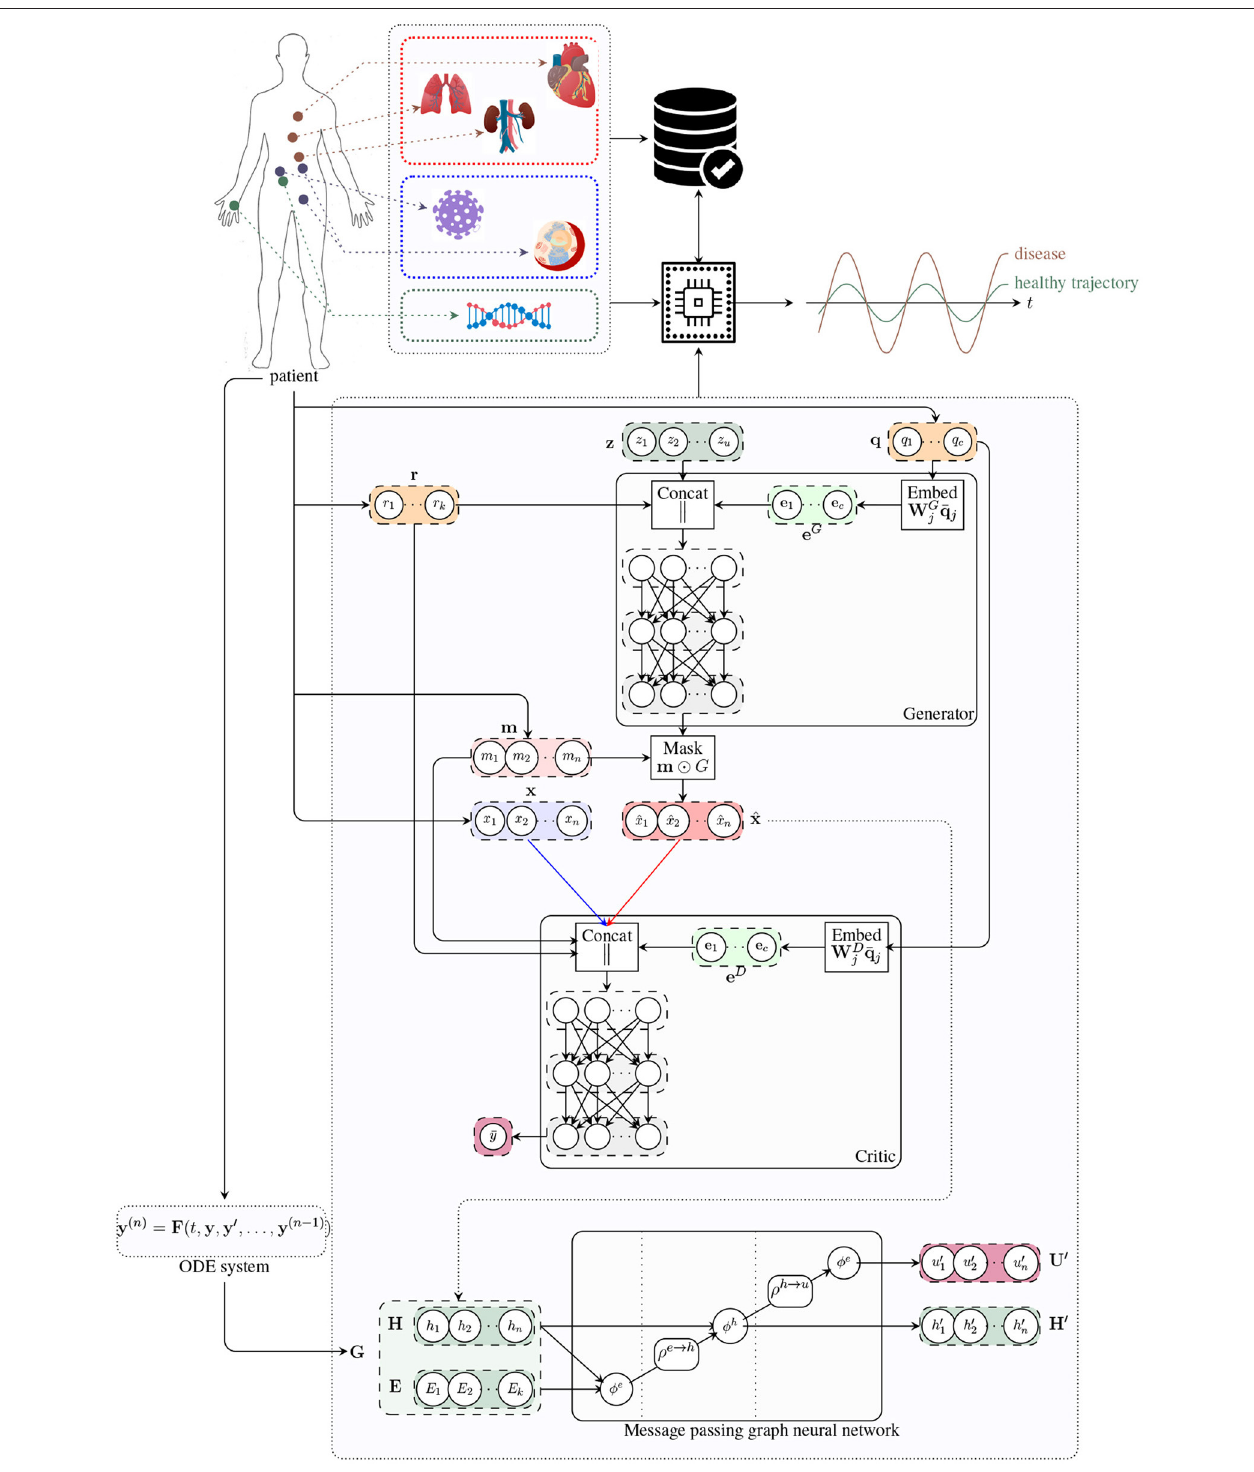
FIGURE 1 | Architecture of the digital twin model. The generator receives a noise vector z, and categorical (e.g. tissue type; q) and numerical (e.g. age; r) covariates, and outputs a vector of synthetic data (ˆx). The critic receives data from two input streams (real, blue; and synthetic, red), a mask m indicating which components of the input vector are missing, and the numerical r and categorical q covariates. The critic produces an unbounded scalar y that quantifies the degree of realism of the input samples from the two input streams. The handcrafted ODE system proposed in Barbiero and Lió (2020) is used to determine a graph representation of patient’s physiology. The message passing neural network updates latent node features to estimate global attributes describing the evolution of the underlying physiological system.